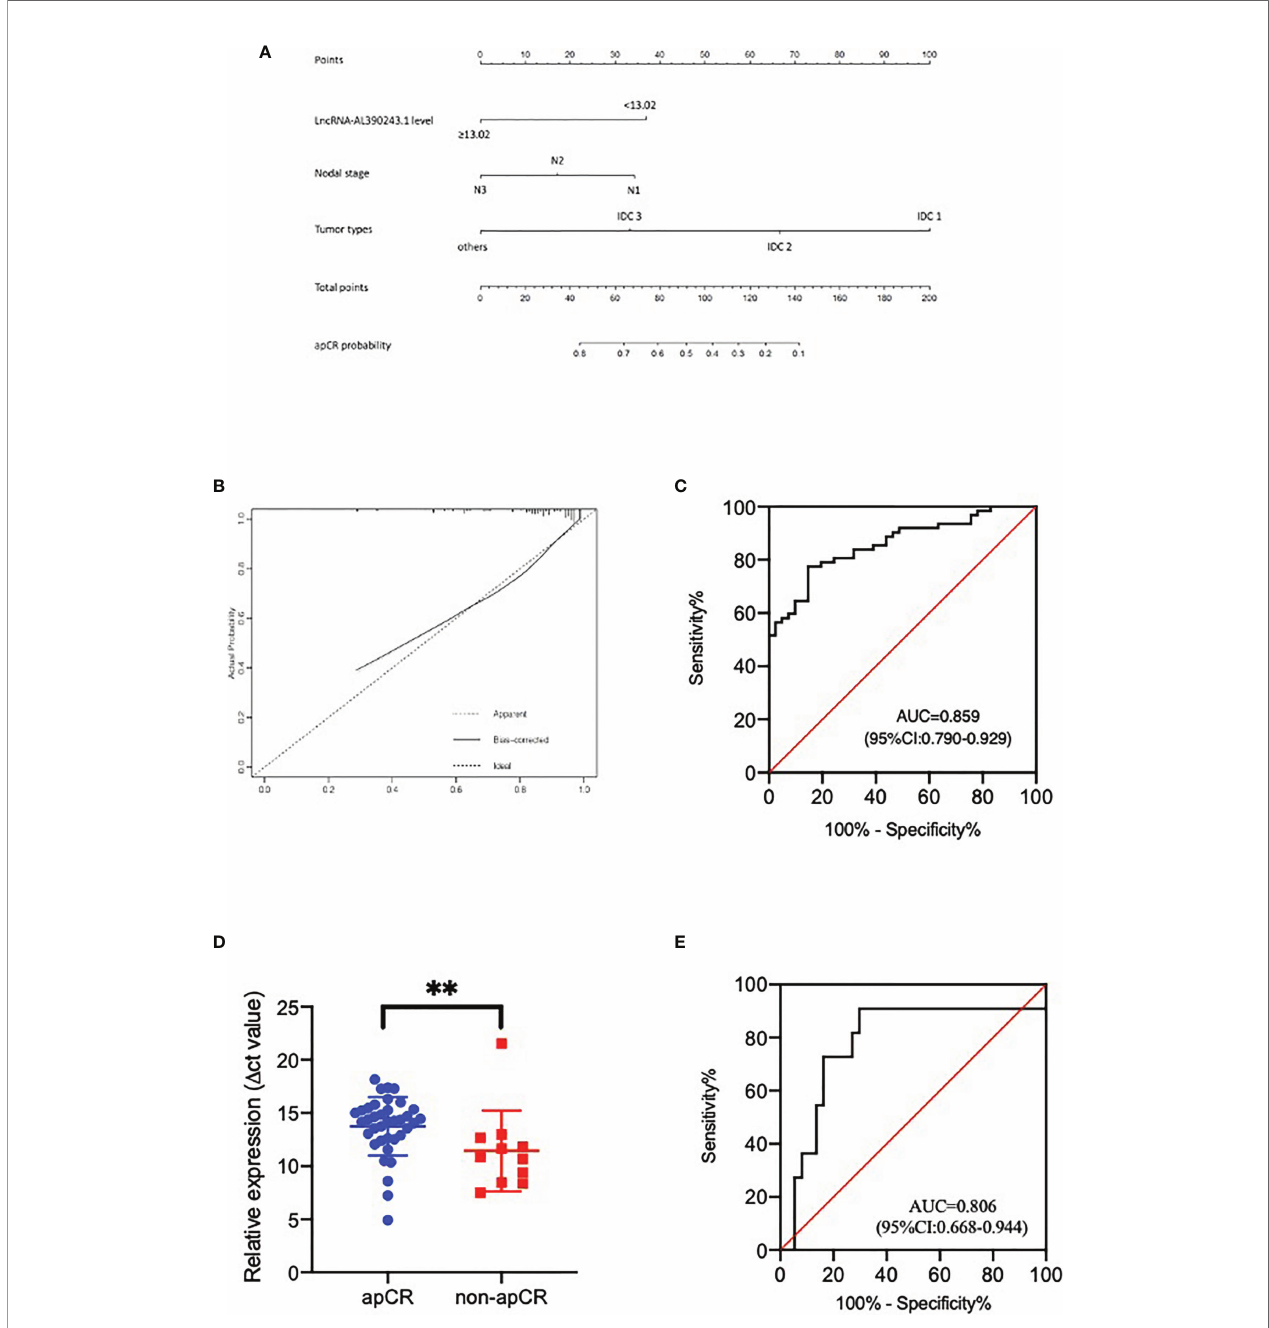
FIGURE 4 | (A) The nomogram to predict patients with apCR. To calculate the probability of apCR, the scores for the three factors were summed up. And the total scores and bottom risk scale were referenced. (B) The calibration curve showed a satisfactory fi t between the predictive and actual observation. (C) The ROC curve of the nomogram. (D) The different expression of lncRNA-AL390243.1 in tissues in the apCR group and non-apCR group among patients with cN 1 disease. **p < 0.005. (E) The AUC of lncRNA-AL390243.1 was 0.806 among patients with cN 1